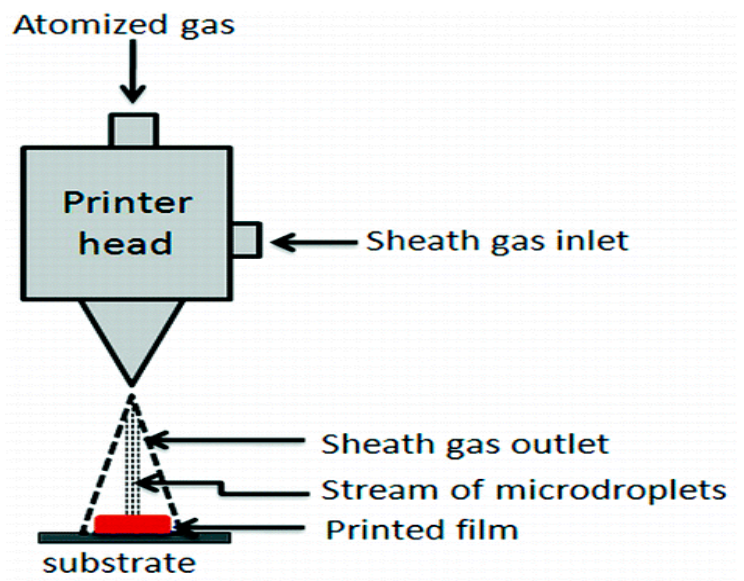
Figure 4. Working principle of aerosol jet three-dimensional printing [79] .